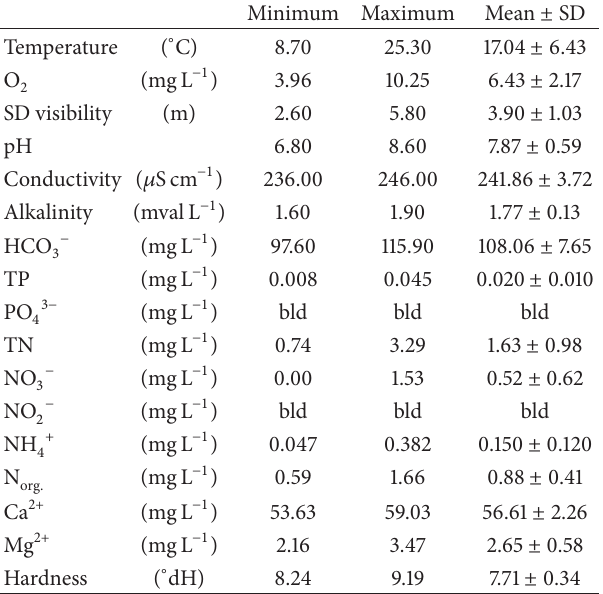
Table 1: Variability of physicochemical parameters in pelagial water in Lake Jasne. Summarized data for the whole study period (April– October). TN: total nitrogen, TP: total phosphorus, and bld: below the limit of